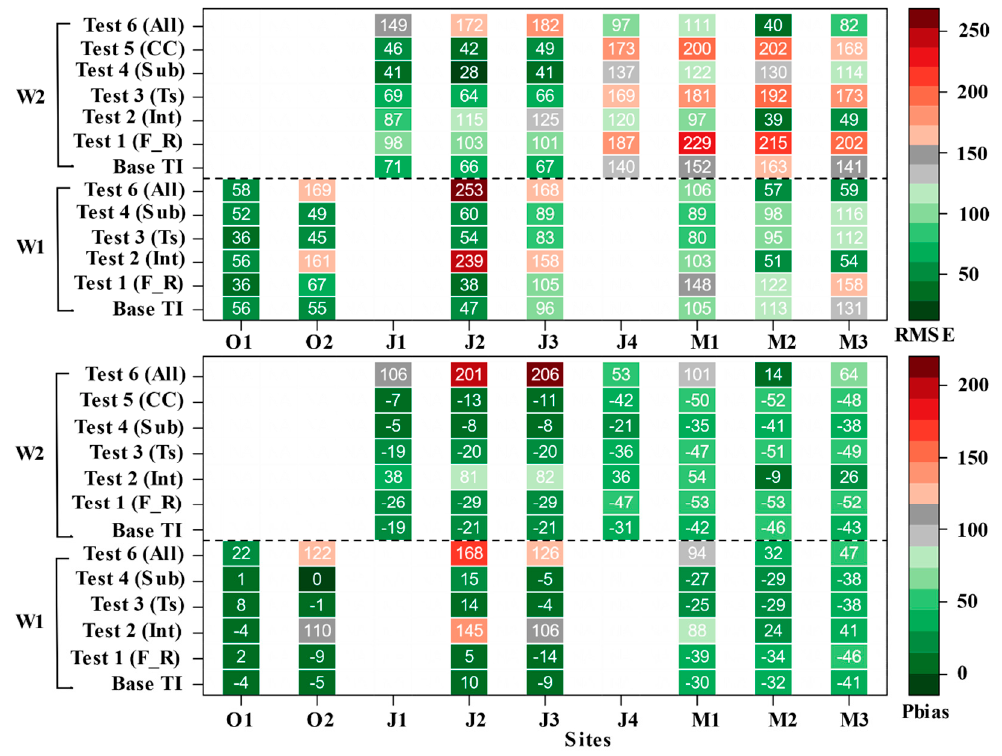
Figure 8. Model performance expressed in terms of the RMSE (mm w.e.) and Pbias (%) for all tests. F_R indicates forest and radiation, Int is snow interception, Ts is snow surface temperature, Sub is sublimation, and CC is cold content. The results are given separately for W1 and W2. The colours of the bar denote absolute values.